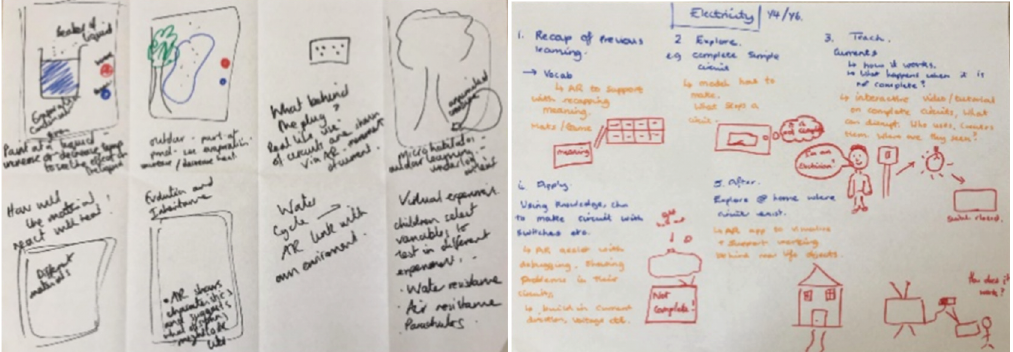
Figure 4. Examples of teachers Crazy 8 & Part Sketching (Design Sprint)